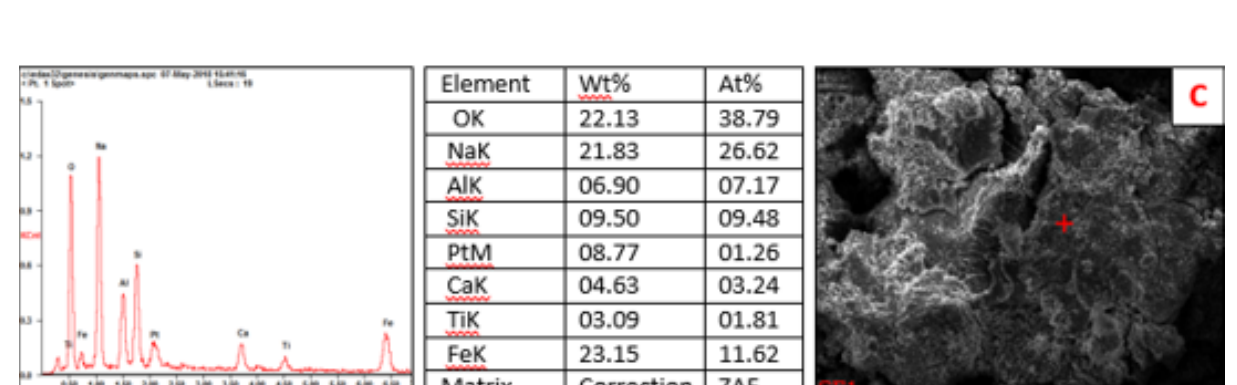
and replaced by particulates of different intensity and